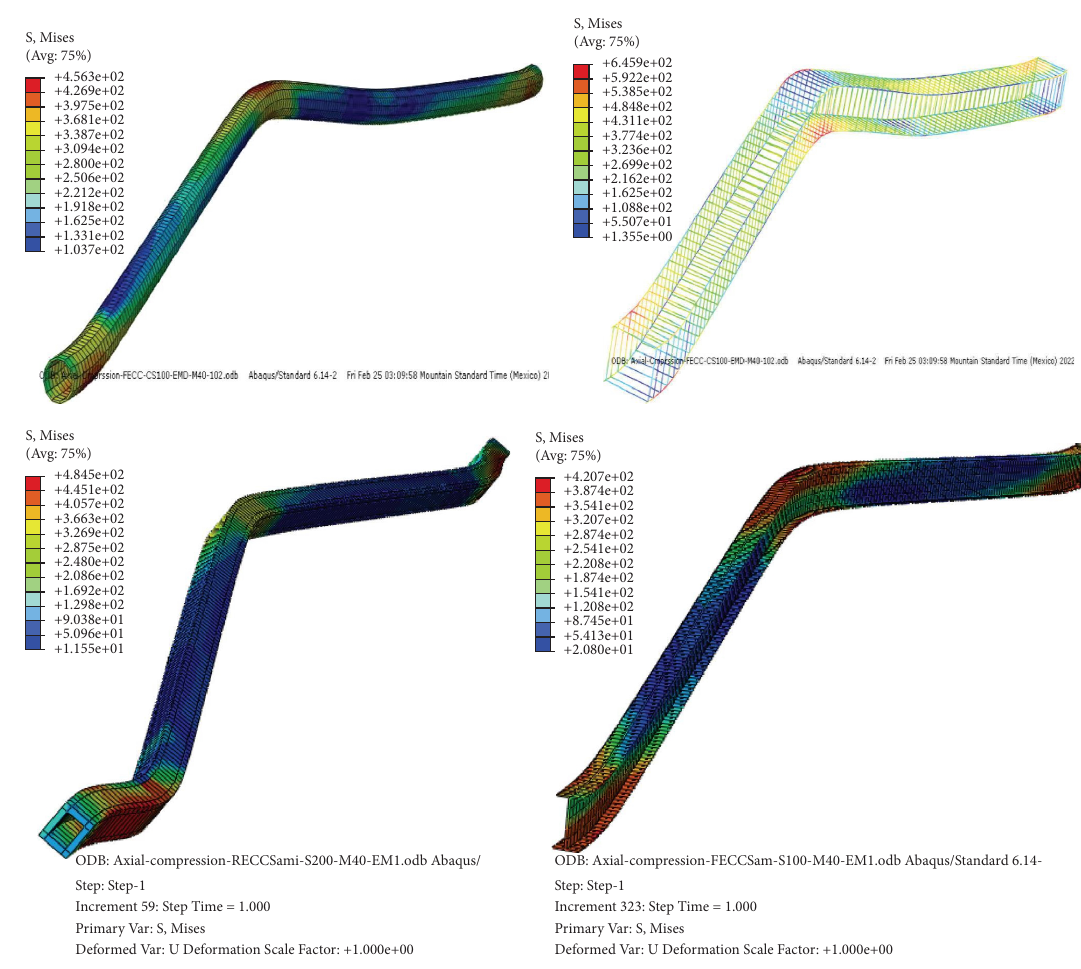
Figure 12: Deformed shape with stress contour of structural steel and rebar at